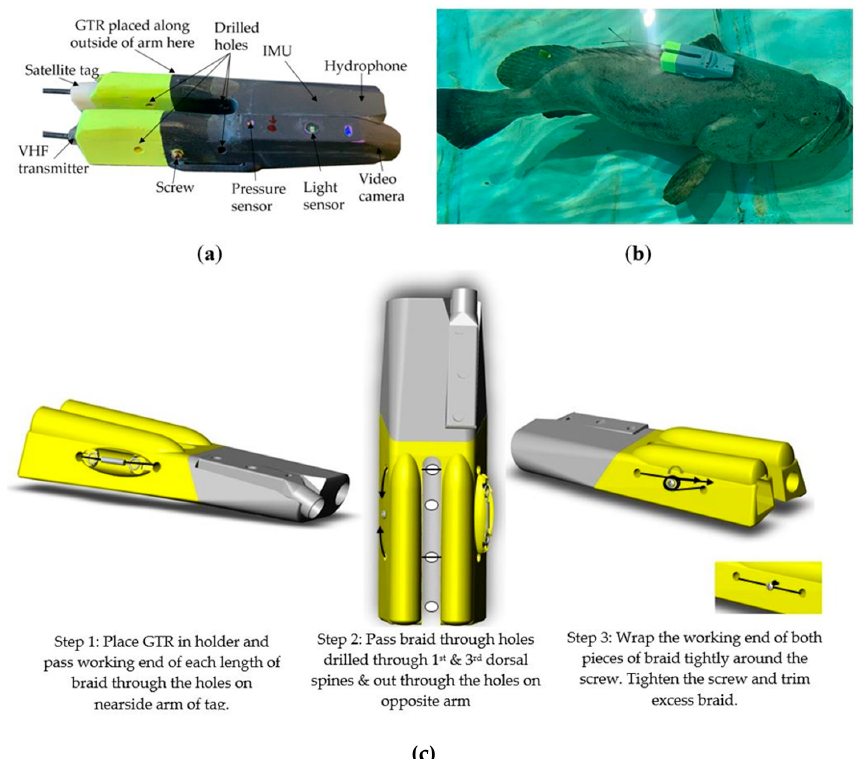
Figure 3. Custom-designed bio-logging tag used on Goliath grouper: ( a ) the components of the tag; ( b ) attachment location of the tag; ( c ) the tag attachment process GTR = galvanic timed